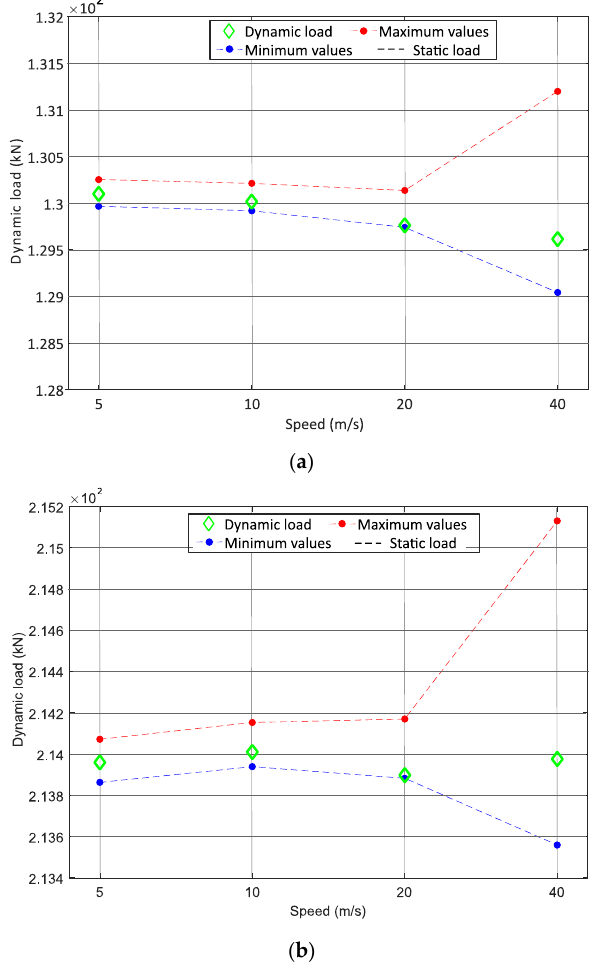
Figure 12. Graphical representation of the confidence interval ( a ): Alfa Pendular vehicle, ( b ): freight wagon.